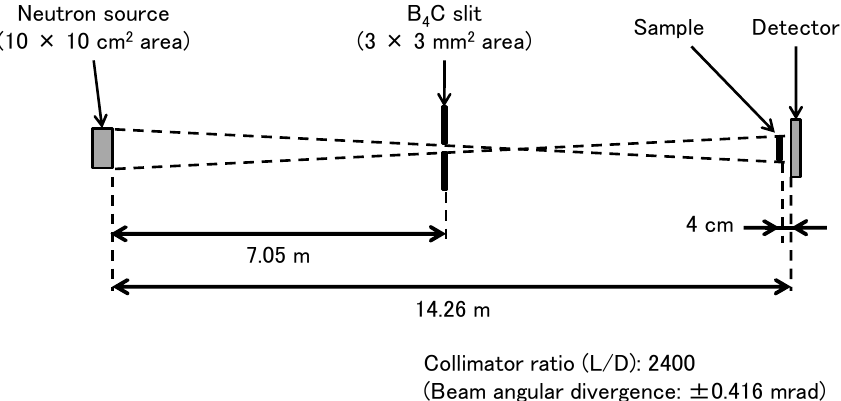
Figure 2. Schematic of setup of pulsed neutron transmission imaging experiment.